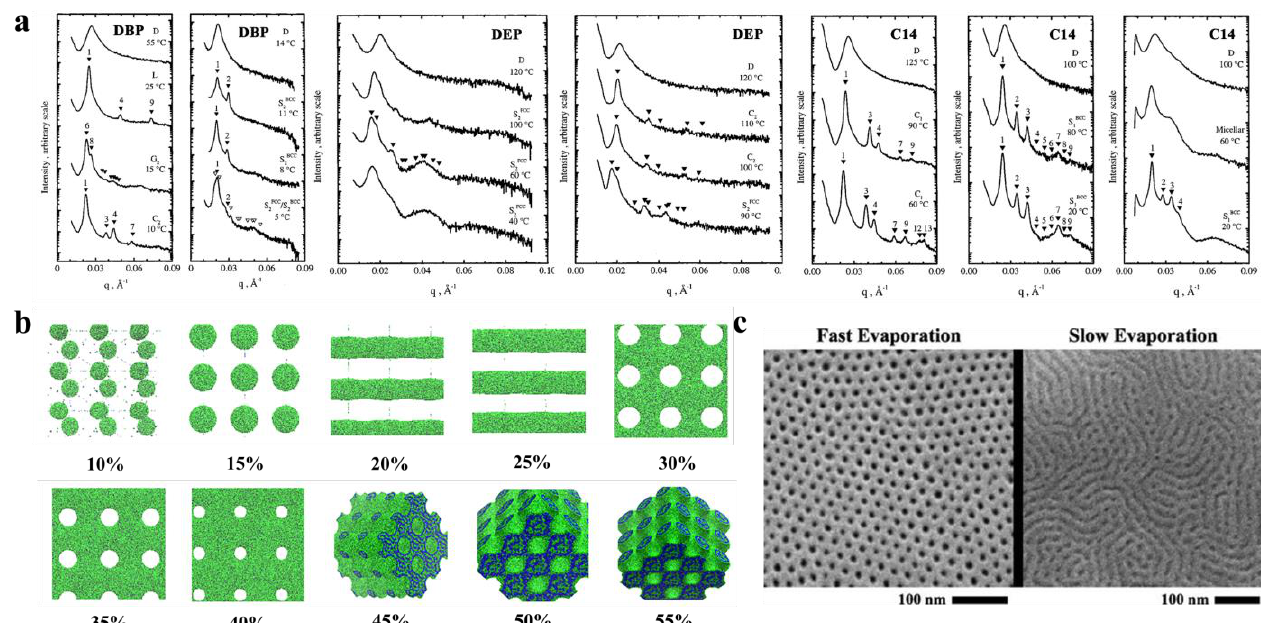
Figure 3. ( a ) Representative SAXS profiles as a function of temperature for DBP, DEP, and C14 solutions [55]. ( b ) Nanoscale morphology diagram of PS-b-PMMA porous membrane simulated by DPD when dissolved in tetrahydrofuran solvent at different polymer concentrations. PMMA is shown in green, and PS is shown in blue [59]. ( c ) SEM images of different morphologies formed by PS-b-PLA at varied solvent evaporation rates [62].